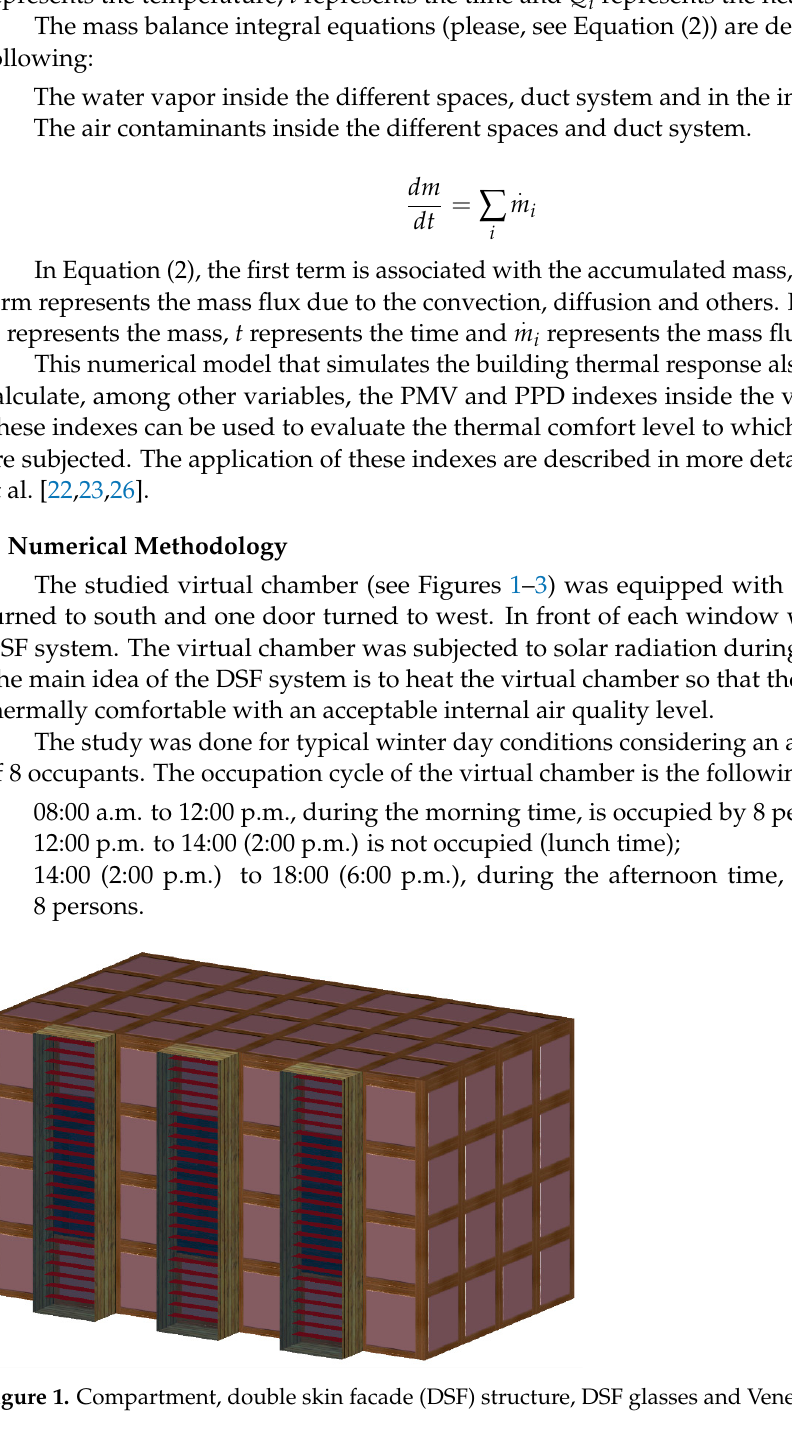
Figure 2. DSF structure, DSF glasses and Venetian-type blind.